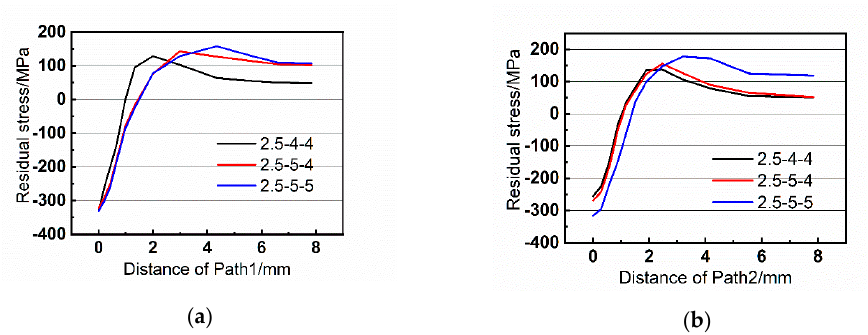
Figure 14. Residual stress of the paths with strap thickness of 2.5 mm. ( a ) Path1 and ( b ) Path2.